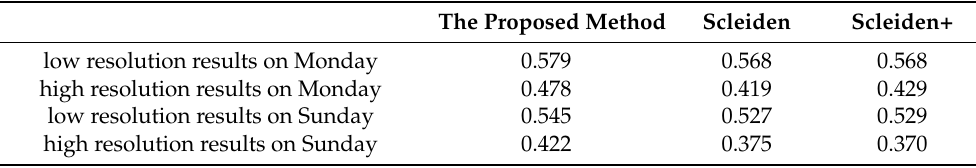
Table 3. Modularity values of the spatial communities identified by the proposed method, Scleiden, and Scleiden+ during morning rush